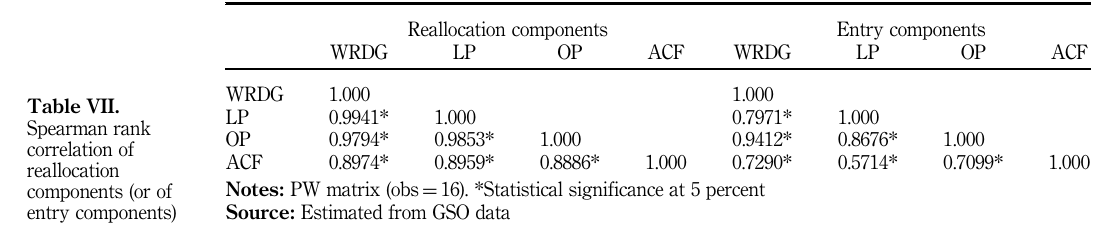
Table VI. Spearman rank correlation of total change components (or of firm improvement components)